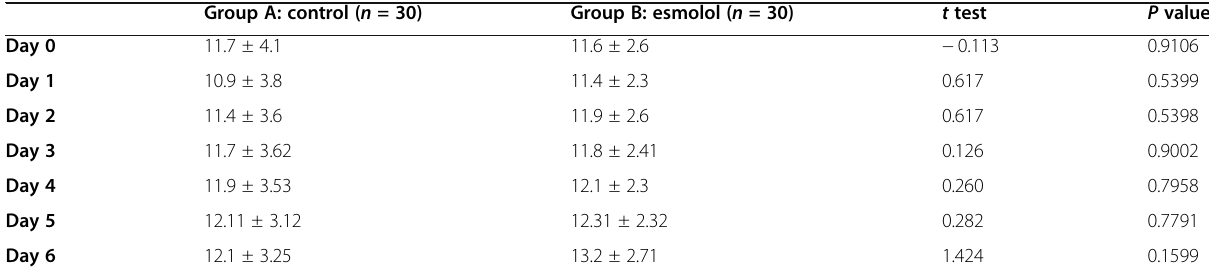
Table 6 Comparison between both groups according to